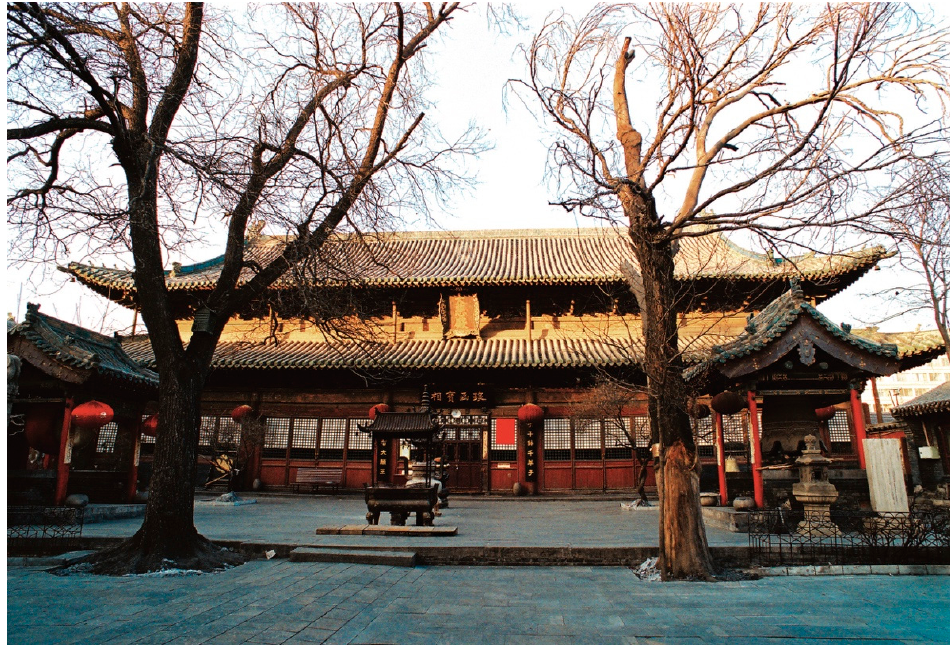
Figure 1. The Great Compassion Hall of Chongshansi (photo by Chongshansi, 2006, and provided by Chongshansi).